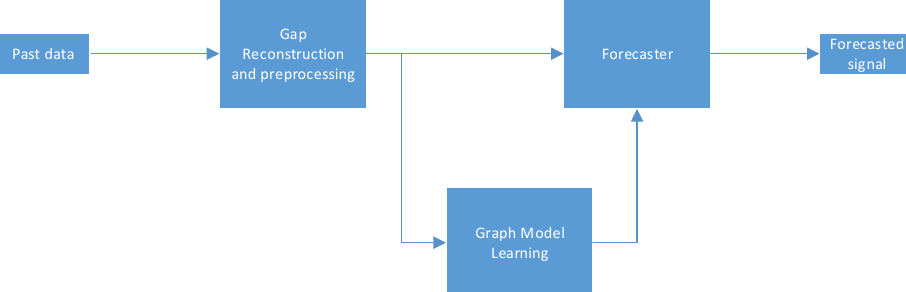
Figure 1. Block diagram of the proposed approach for robust photovoltaic (PV) production